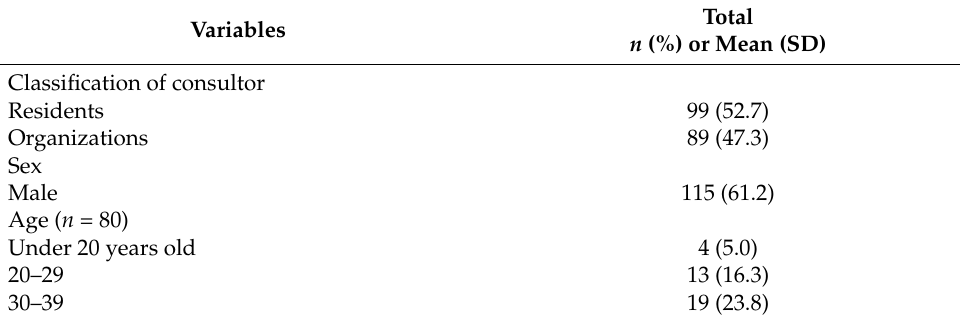
Table 1. Characteristics of COVID-19-related free telephone consultation cases ( n =